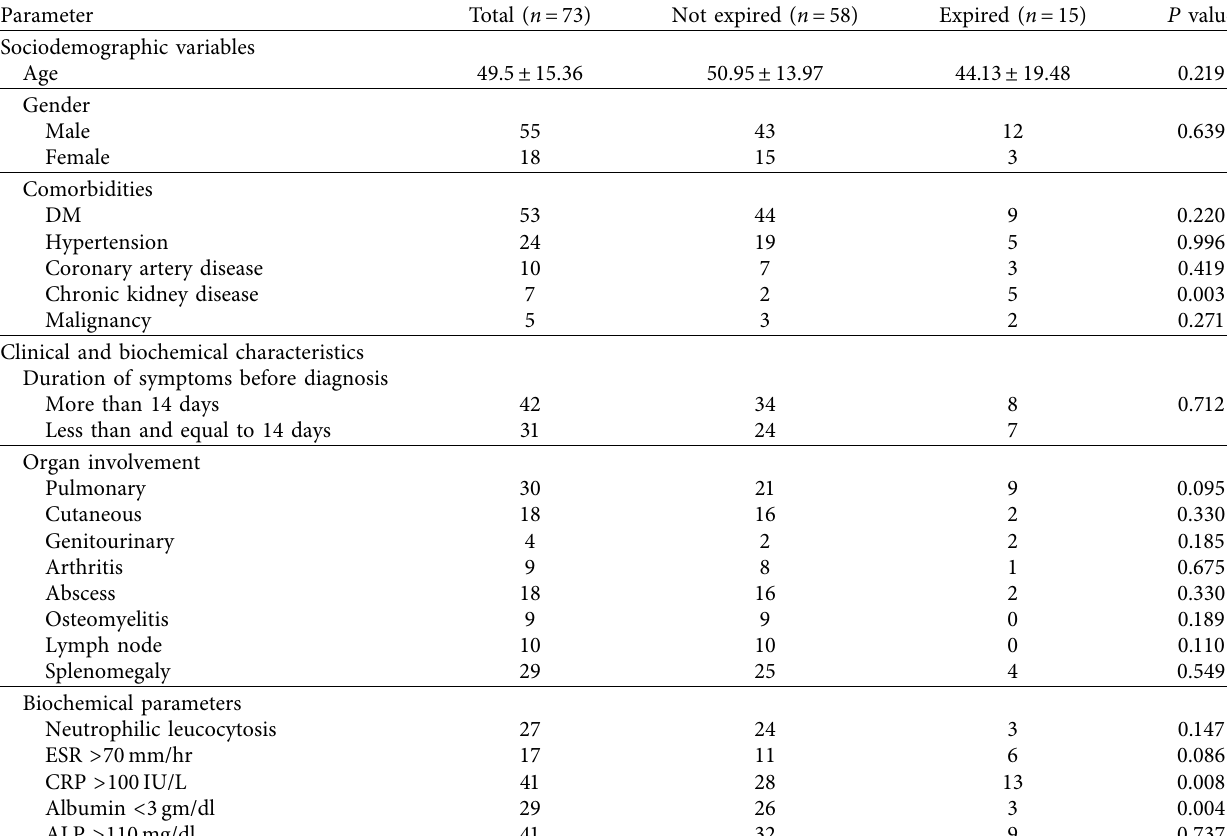
Table 2: Demographic, clinical, and laboratory results stratified for mortality.